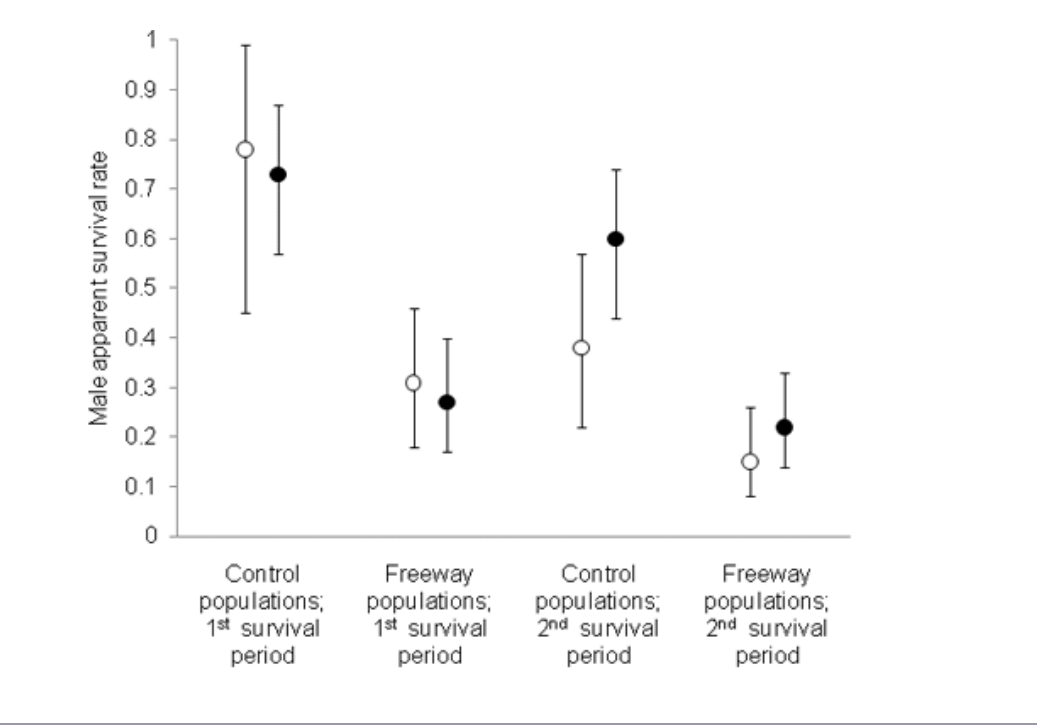
Fig. 2 . Apparent annual survival rate of male squirrel gliders ( Petaurus norfolcensis ) in control and freeway populations. Open circles are mean estimates with vague priors; shaded circles are estimates with informative priors. Bars are 95% credible intervals. Survival period refers to either of two time intervals over which apparent survival rates were estimated. The first survival period includes trap sessions between August 2005 and December 2006; the second includes sessions between January 2007 and February